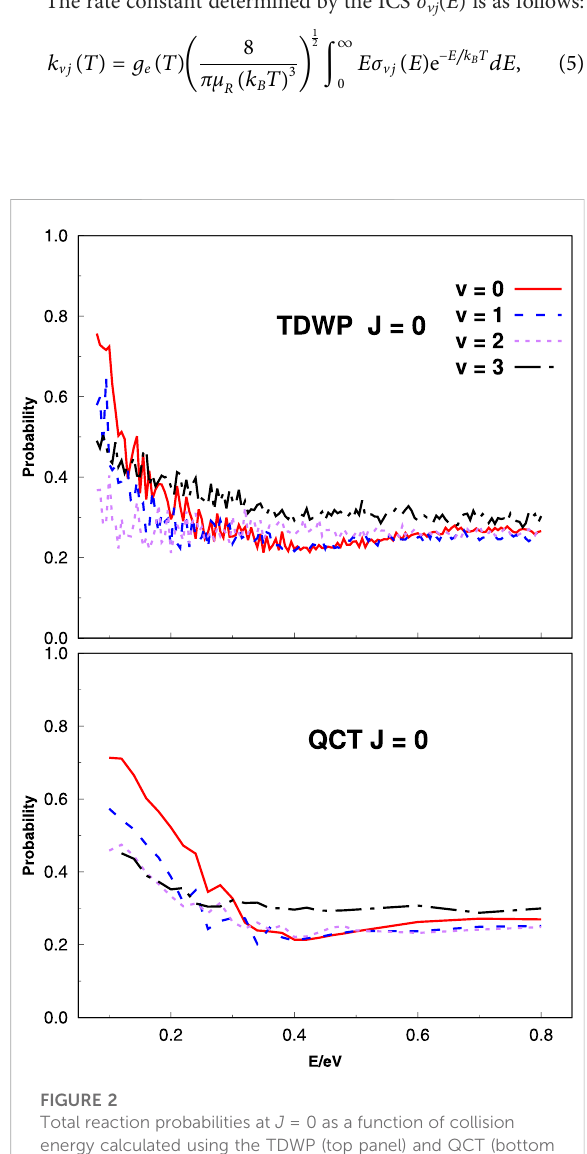
FIGURE 2 Total reaction probabilities at J = 0 as a function of collision energy calculated using the TDWP (top panel) and QCT (bottom panel)methodsforvariousinitialvibrationalstatesoftheSHforthe title